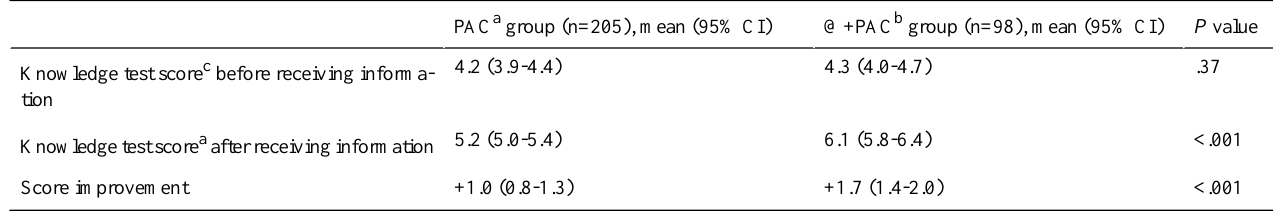
Table 2. Anesthesia knowledge test results.